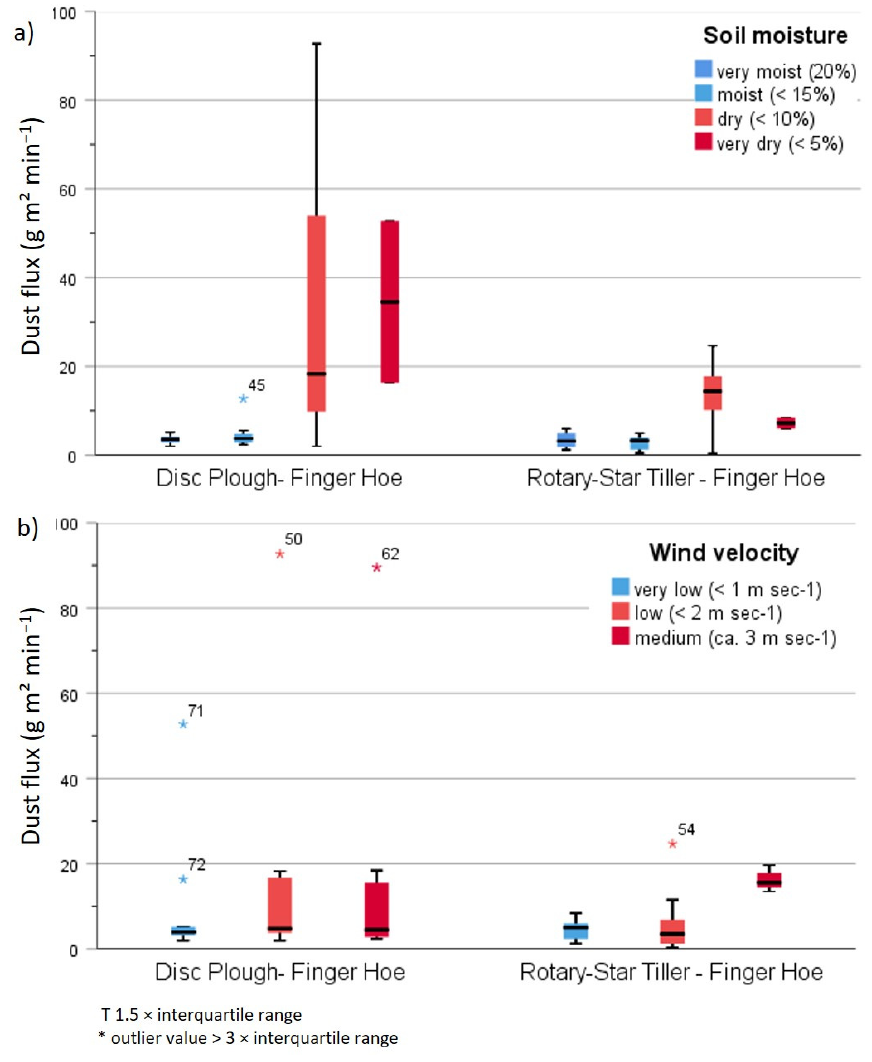
Figure 7. Measured dust flux related to relative categories ( a ) soil moisture ( b ) wind velocity. Table 4. Mean dust flux for categories soil moisture and wind